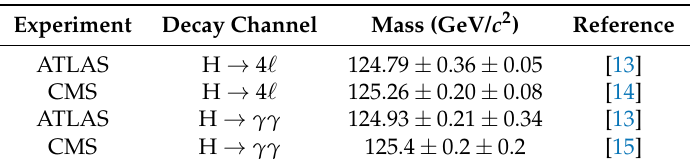
Figure 7. New measurements of the mass of the Higgs boson by the ATLAS [13] and CMS [14] Collaborations at the LHC at 13TeV p-p collision energy using the H → γγ decay channel. Table 3. New mass values for the Higgs boson measured by ATLAS [13] and CMS [14] at 13TeV p-p collision energy. The first uncertainty is statistical, the second one systematic. Note the remarkable agreement between channels and